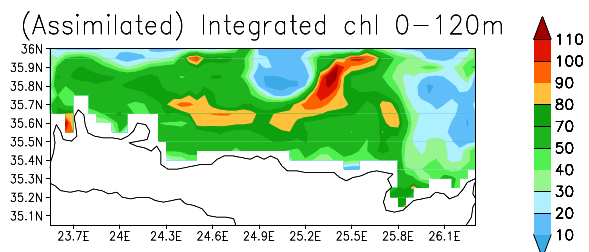
Fig. 9. Integrated chlorophyll concentrations (mg/m 3 ) between 0m–120m from the free run, the reference run, as estimated by the SEPLEK filter.